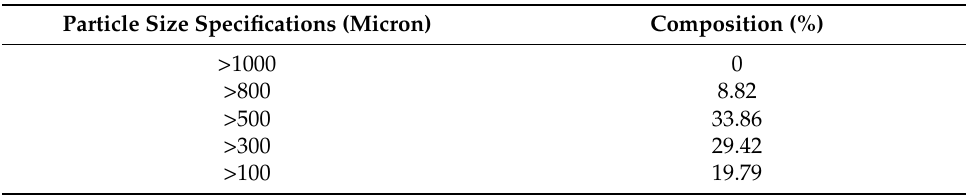
Table 1. Grain size specification and distribution for PA6 powder.